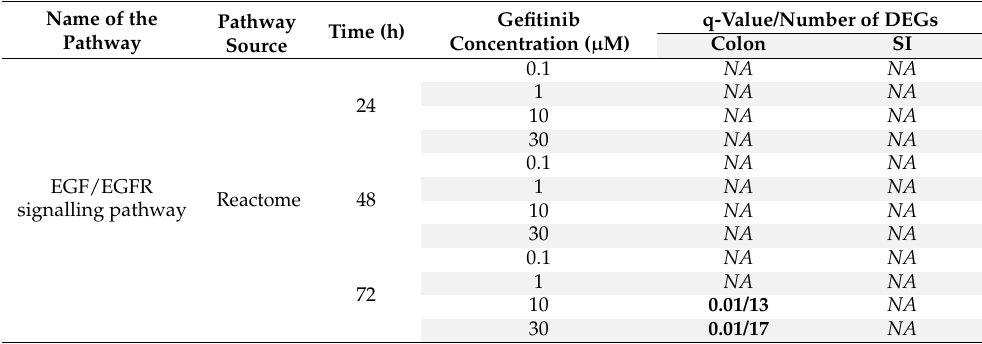
Table 2. Most relevant on-target pathways perturbed by gefitinib.